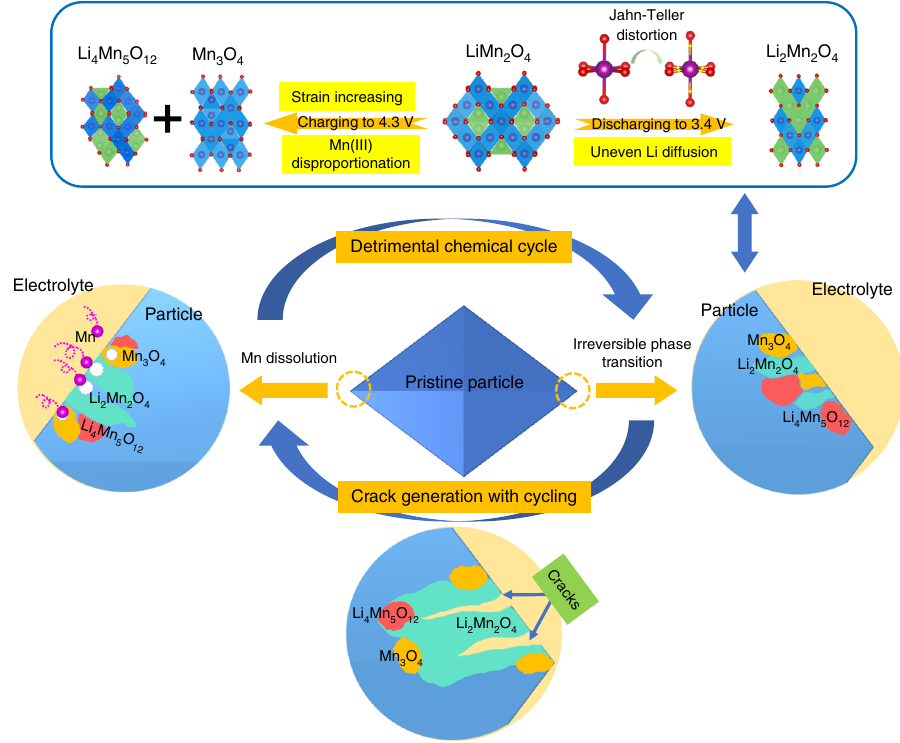
Fig. 5 Schematic of the vicious cycle with Mn dissolution and irreversible phase transition, as well as crack generation with